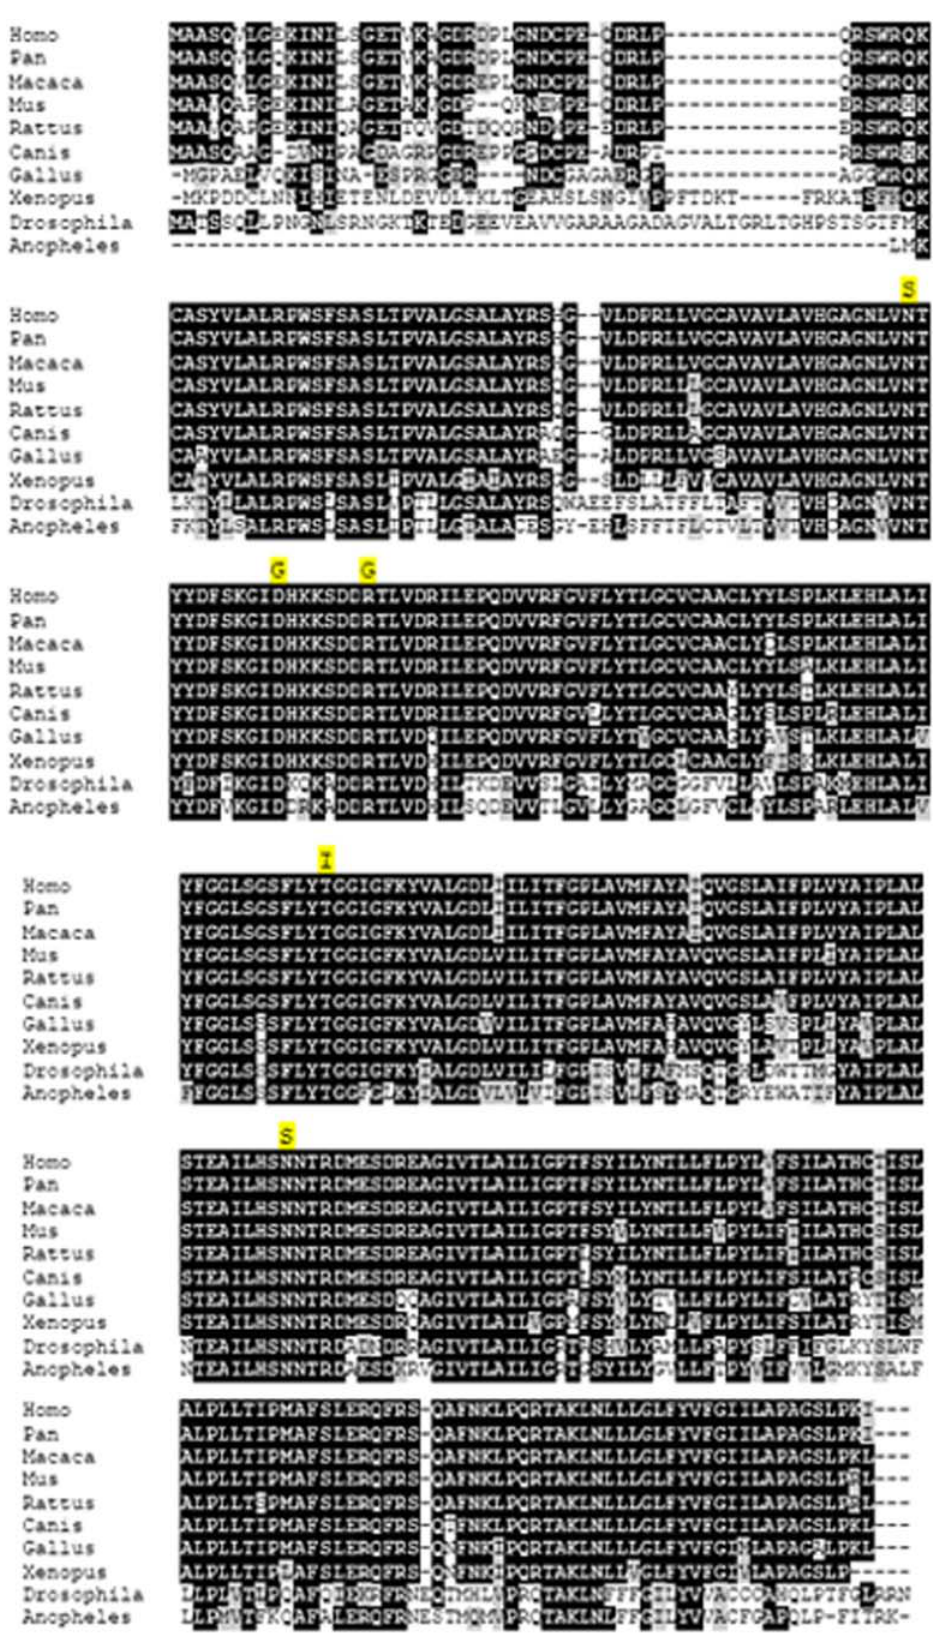
Figure 4. ClustalW alignment of vertebrate and invertebrate UBIAD1 putative orthologs. The five familial mutations are highlighted in yellow above the mutated residue.